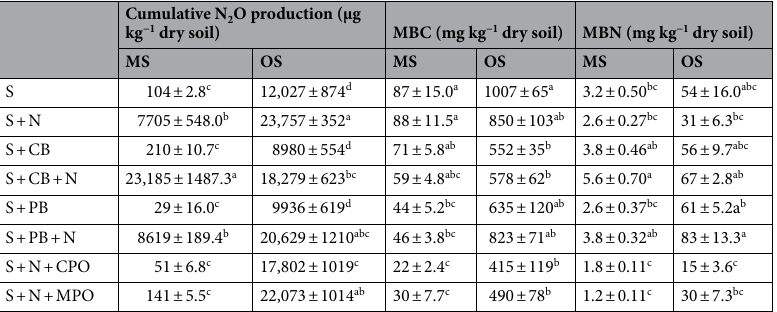
Table 1. Total N 2 O production, microbial biomass C (MBC) and microbial biomass N (MBN) (mean ± standard error, n = 3) in two studied soils [organic soil (OS) and mineral soil (MS)] as influenced by biochar and soil oxygen fertilizers with or without N at the end of incubation. S = Control soil only; S + N = Control soil with N fertilizer; S + CB = Control soil with corn residue biochar; S + CB + N = Control soil with corn residue biochar and N fertilizer; S + PB = Control soil with pine bark biochar; S + PB + N = Control soil with pine bark biochar and N fertilizer; S + N + CPO = Control soil with N fertilizer and calcium peroxide; S + N + MPO = Control soil with N fertilizer and magnesium peroxide. Values in each column followed by similar letter are not statistically different from each other by Duncan Multiple Range Test at P =